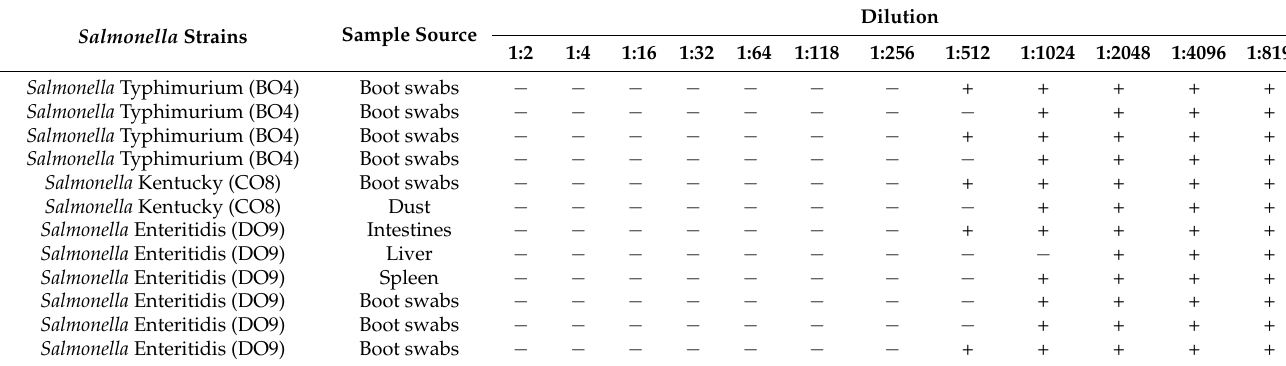
Table 3. MIC of analyzed